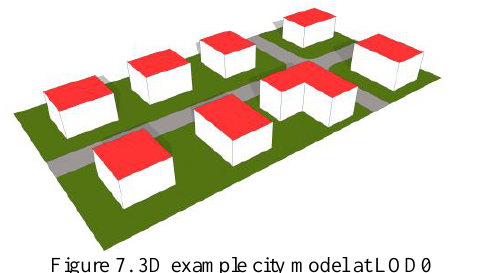
Figure 7. 3D example city model at LOD0